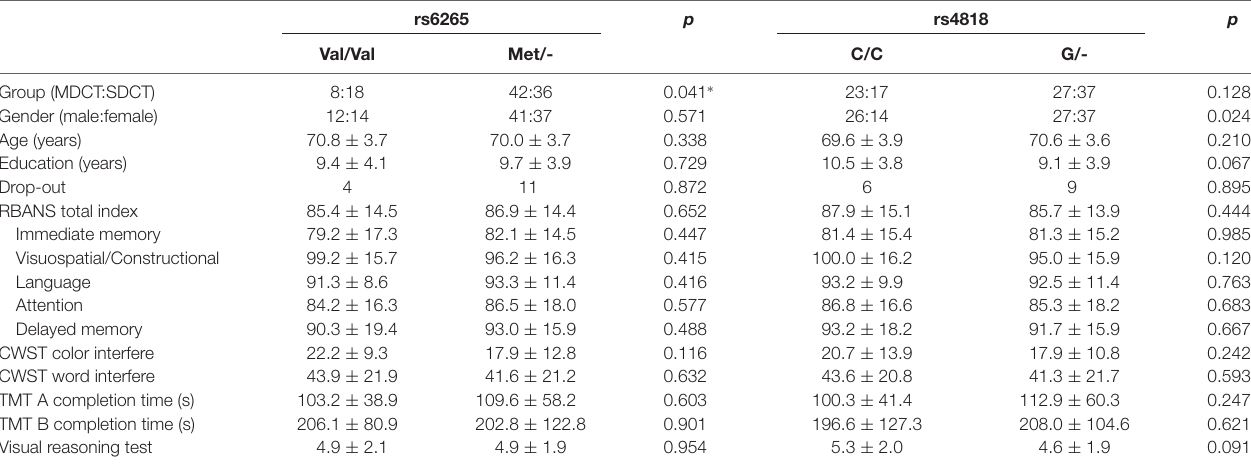
TABLE 2 | Demographic characteristics and baseline cognitive function by genotype